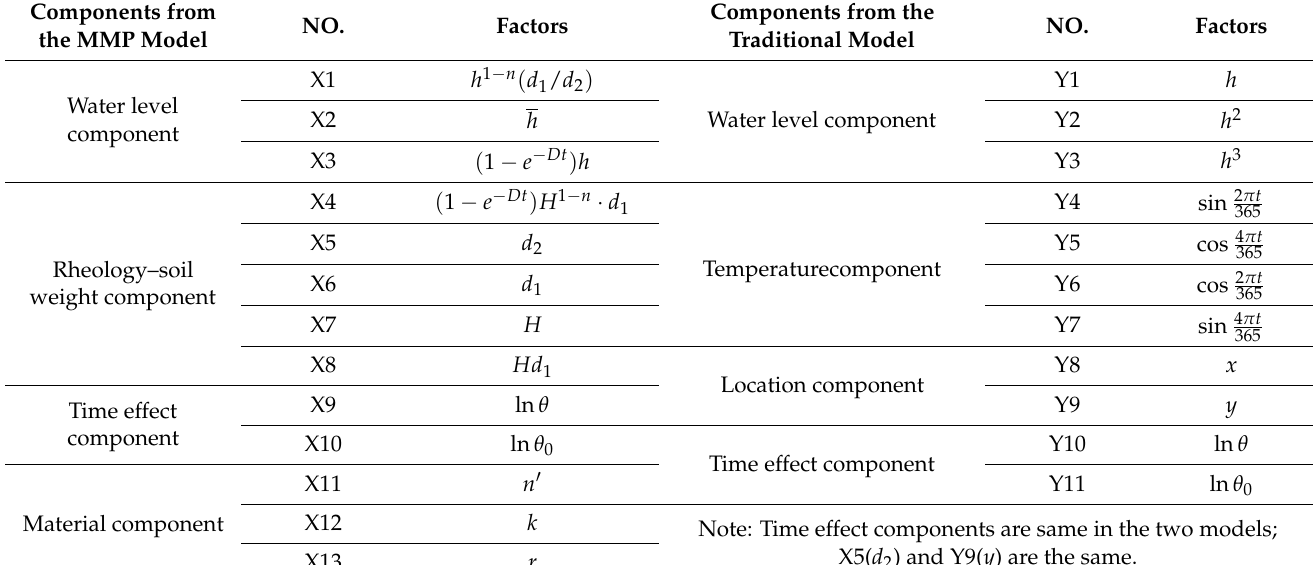
Table 3. Influence variables